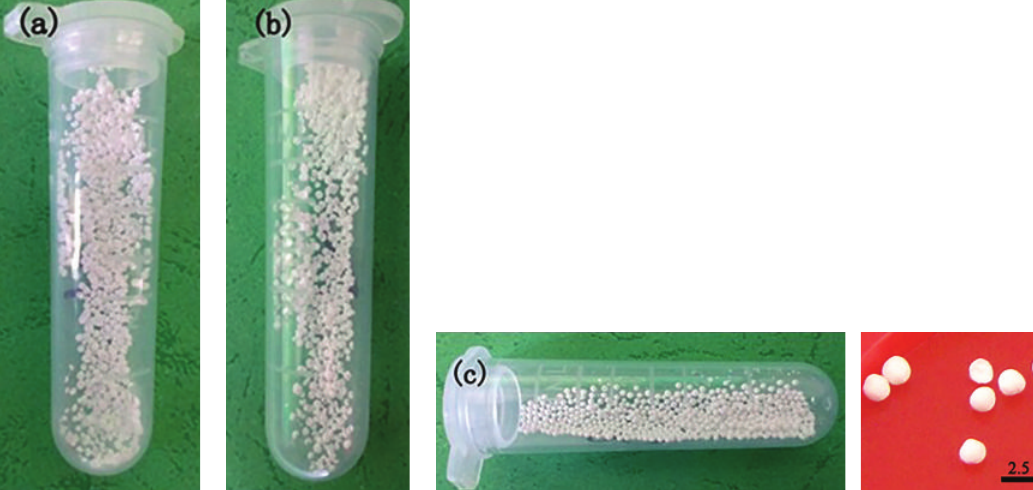
Figure 1: Photographs of TiO 2 aerogel: (a) aspherical TiO 2 aerogel-0.1 mL of TBOT, (b) aspherical TiO 2 aerogel-0.5 mL of TBOT, and (c) spherical TiO 2 aerogel-5.0 mL of TBOT.